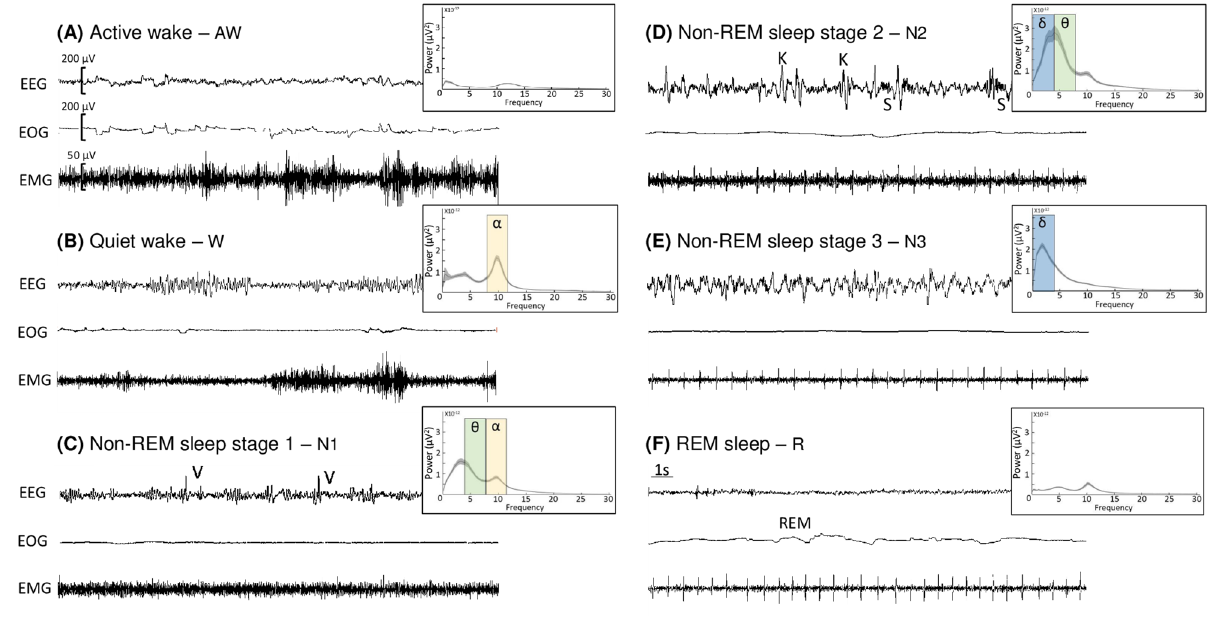
Figure 6. Polysomnographic recordings for sleep/wake stages analysis. 30 s epochs showing ( A ) active wake state with fast and low-voltage electroencephalogram (EEG), high-amplitude electro-oculogram (EOG) and high electromyogram (EMG) activity, ( B ) quiet wake state with alpha waves (8–12 Hz) on EEG, ( C ) light sleep N1 with mix-frequency (alpha and theta waves) and vertex sharp waves (V) on EEG and reduced muscle tones ( D ) light sleep N2 with predominant theta waves (4–8 Hz), spindles (S) and K complex (K) on EEG, absence of EOG and regular muscle tone, ( E ) deep sleep N3 with ample delta frequencies (0.3–4 Hz) on EEG and reduced muscle tone, and ( F ) REM sleep with sawtooth EEG activity, rapid-eyes movements (REM) on EOG and absence of muscle tone. Mean ± 95% confidence interval of the absolute power (µV 2 ) of the EEG during each wake and sleep stages is shown to the right of EEG